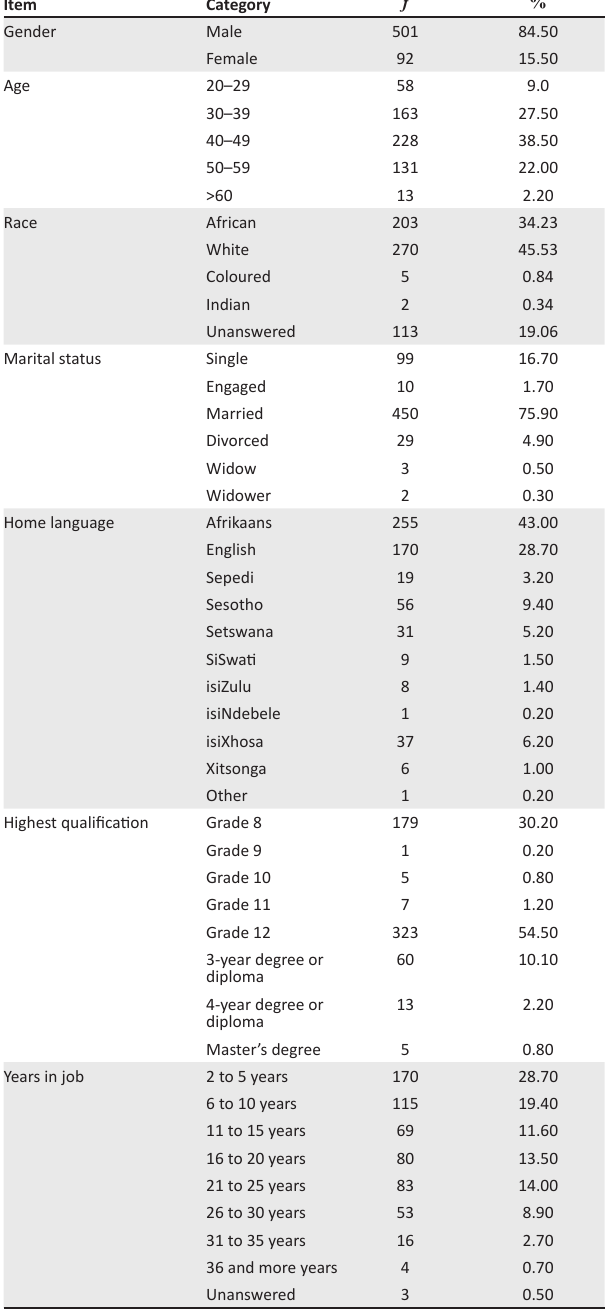
TABLE 1: Characteristics of participants ( n =